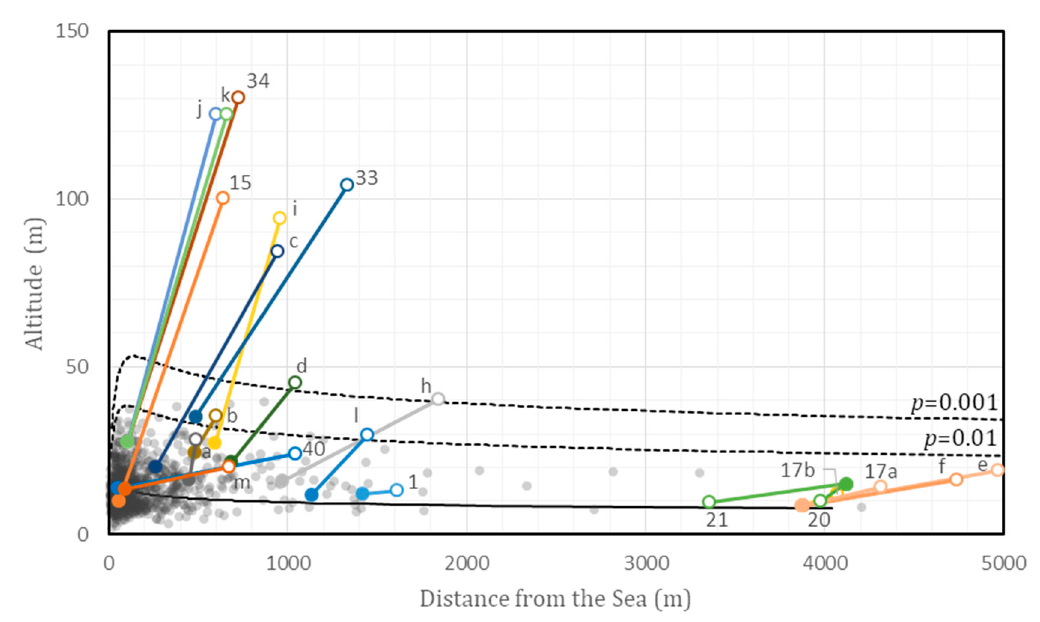
Figure 2. Paired tsunami reach and one-sided prediction intervals of reach of the Tsunami 2011. Tsunami reaches are indicated by tsunami-originated placenames (empty dots) and those of the Great East Japan Earthquake & Tsunami 2011 (filled dots). Distance from the sea is measured along the drainage of the basin. The tsunami reach indicated by a placename is matched to that of Tsunami 2011 in the same drainage basin in the Haraguchi & Iwamatsu map [44]. IDs in the graph correspond to those listed in Table 1. The dashed lines are 99% and 99.9% one-sided prediction interval of the highest tsunami reach of the Tsunami 2011, for drainage basins in Iwate Prefecture (shown with semi-transparent dots) in the TTJS data [45], and the solid line is the mean. The values for each placename is given in